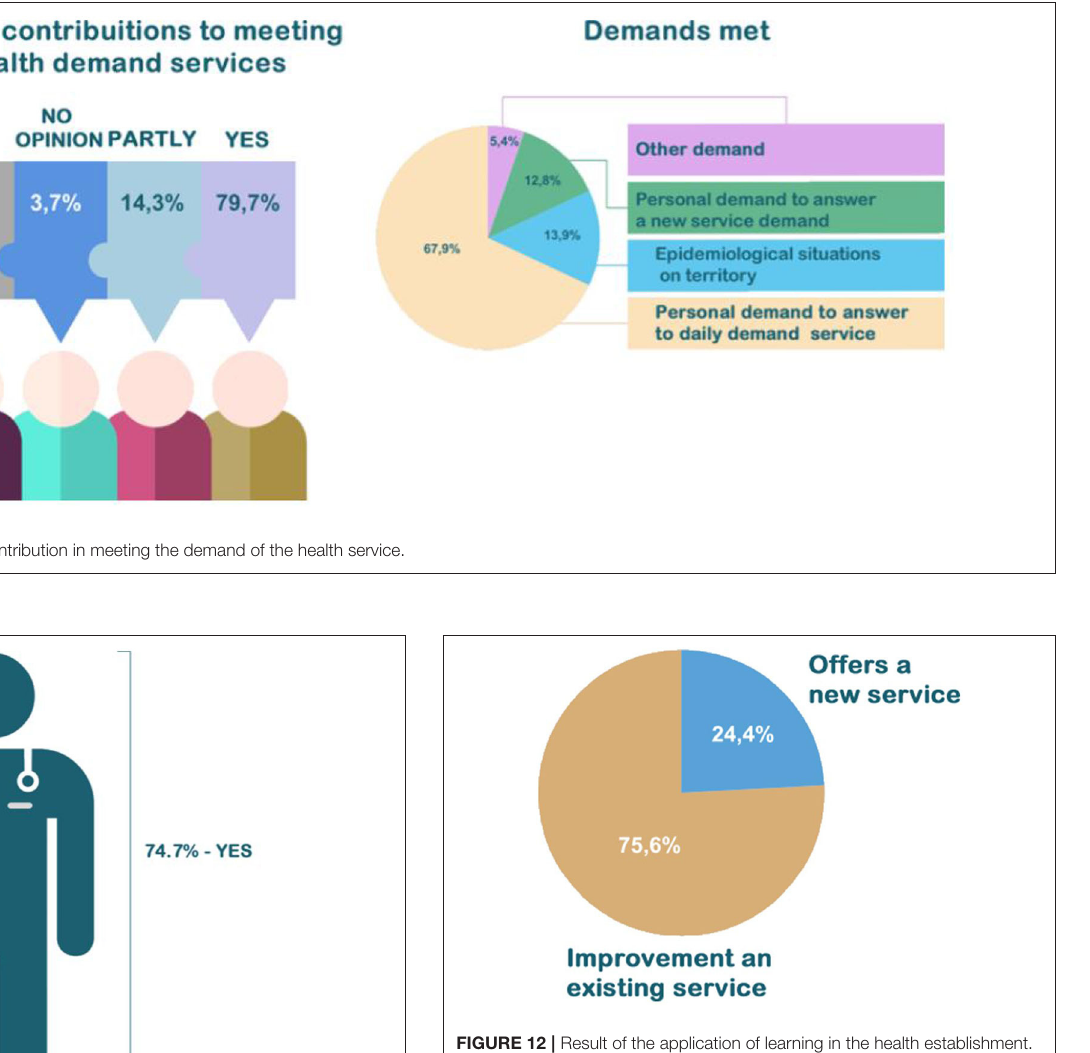
FIGURE 12 | Result of the application of learning in the health